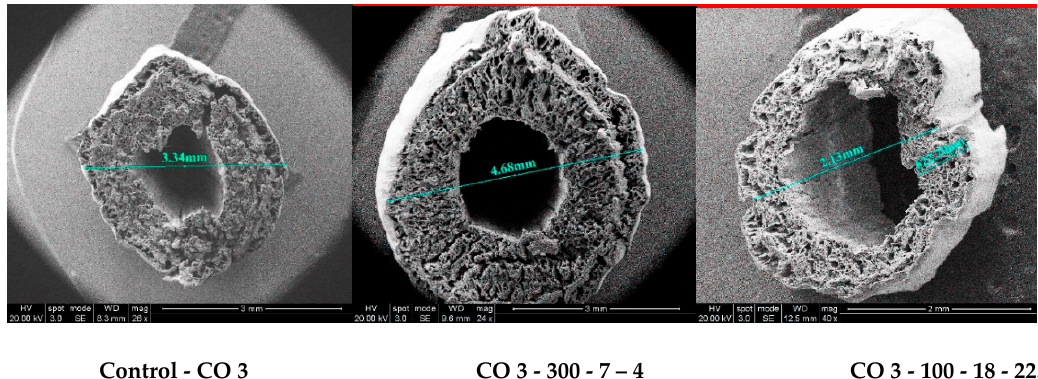
Figure 4. Section of the internodal regions in the wild (CO 3) and extreme mutants studied through scanning electron microscopy (SEM).